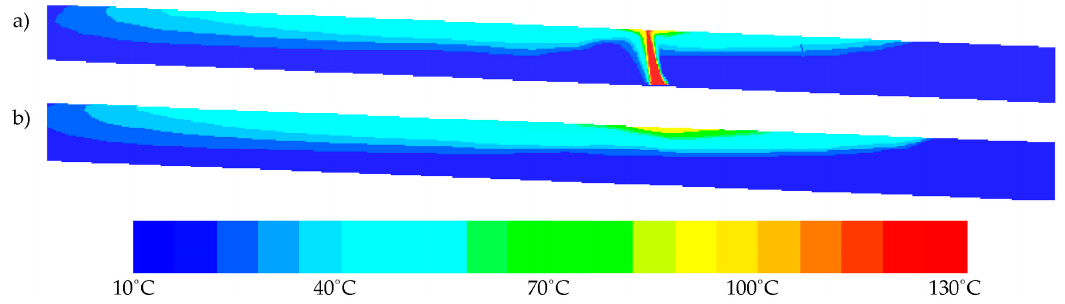
Figure 12. Temperature distributions in 160 s of fire development: ( a ) at a plane of fire source, ( b ) at the tunnel symmetry plane.